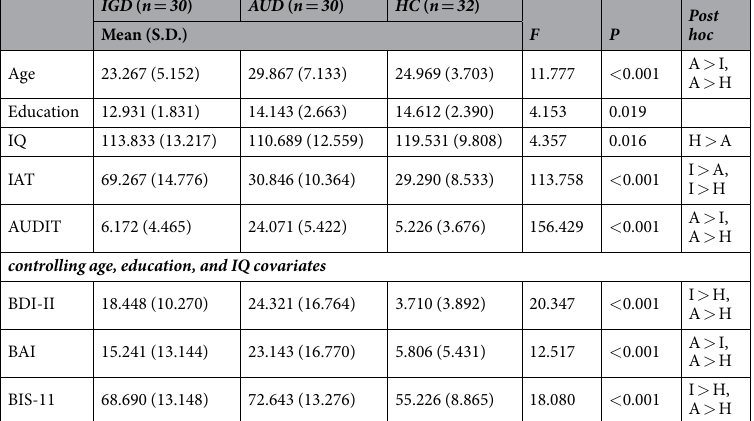
Table 1. Demographic and psychological characteristics of the IGD, AUD, and HC groups. Group differences for demographic and psychological variables were analyzed. Bonferroni correction was applied to the post hoc analyses, and the significance level was set at 0.0167. IGD (I) = Internet gaming disorder; AUD (A) = alcohol use disorder; HC (H) = healthy control; IQ = intelligence quotient; IAT = Young’s Internet Addiction Test; AUDIT = Alcohol Use Disorder Identification Test; BDI-II = Beck Depression Inventory-II; BAI = Beck Anxiety Inventory; and BIS-11 = Barratt Impulsivity